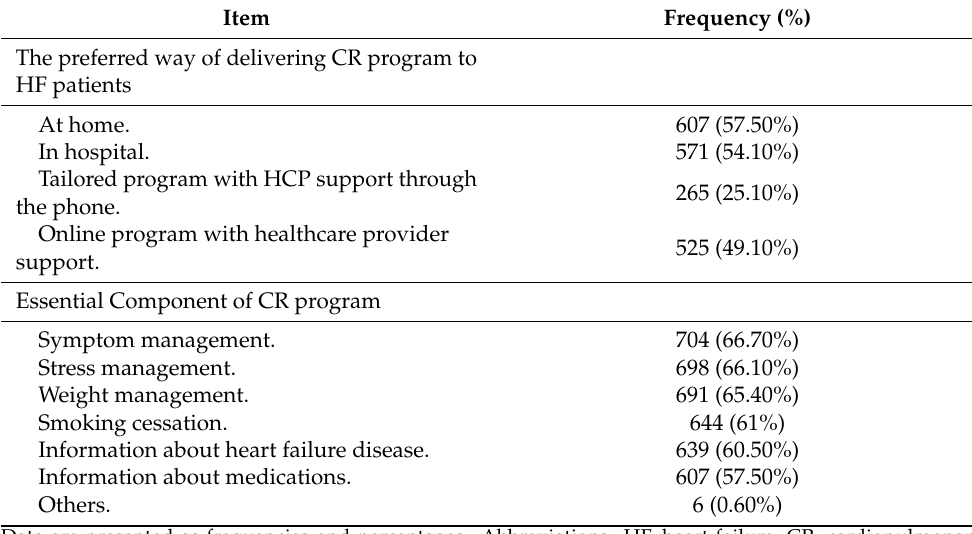
Table 3. Mode of delivery and component of cardiopulmonary rehabilitation ( n =